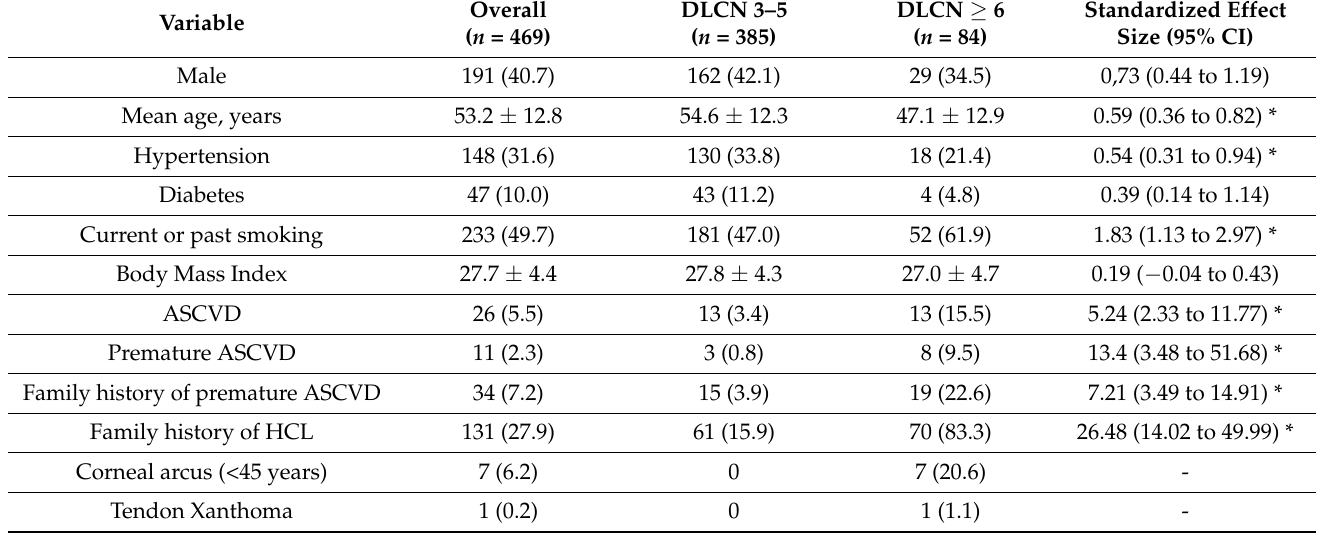
Figure 1. Patient selection: Flowchart showing sequential steps during patient selection. * Selected by means of consecutive sampling. T-Col: Total cholesterol. DLCN: Dutch Lipid Clinic Network. ides. Table 1. Baseline characteristics.